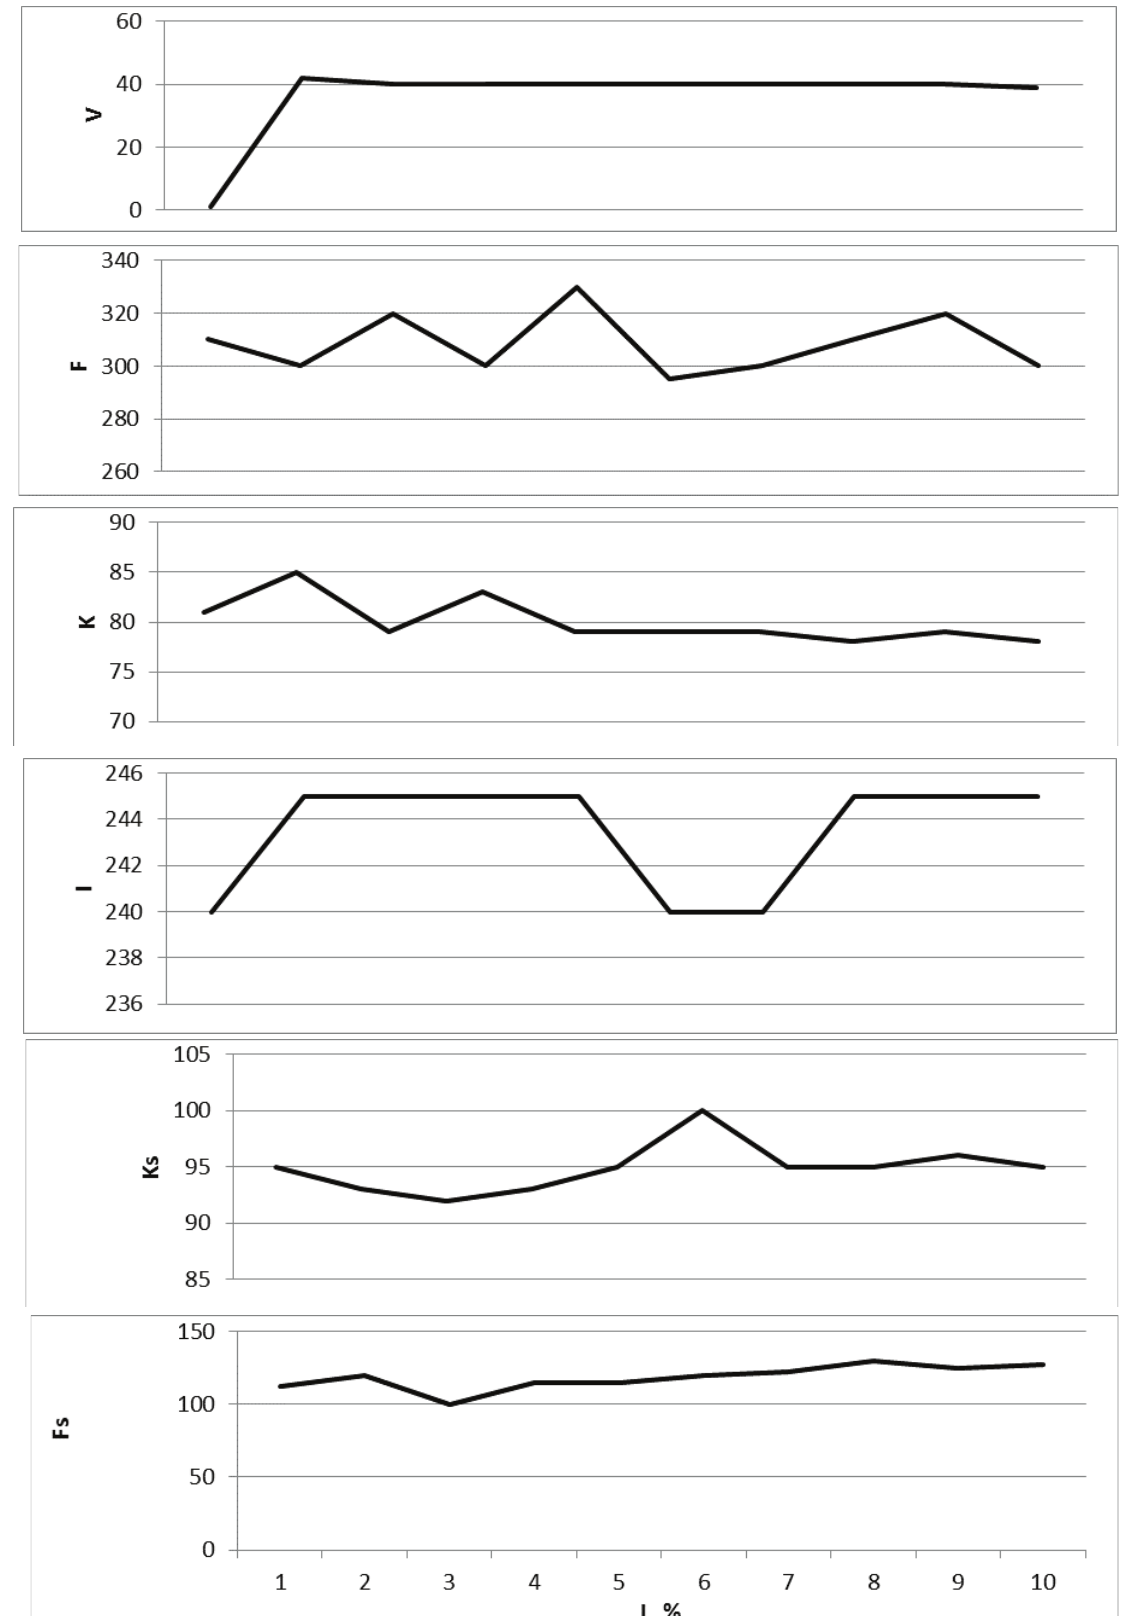
Fig. 1. Dynamic of integral indicators of elite cyclists’ pedaling technique on model distance of pursuit racing: V – speed, km/hr; F – spent forces, N; K – coefficient of force efficiency, %; I – total impulse of force, N•s; Ks – symmetry indicator by coefficient of force efficiency, %; Fs - symmetry indicator by spent forces, %; L – length of distance,